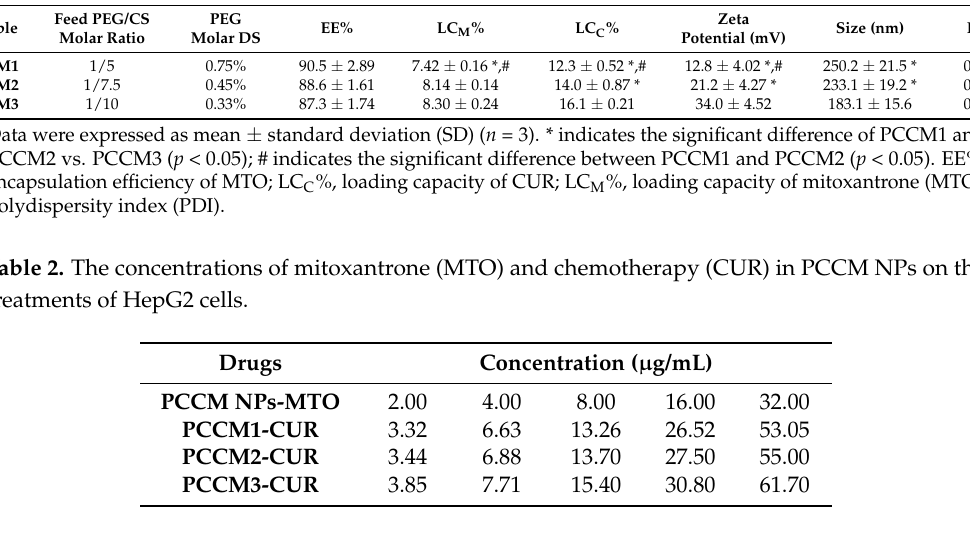
Table 1. Characterization of mitoxantrone-loaded PCC NPs (PCCM NPs).